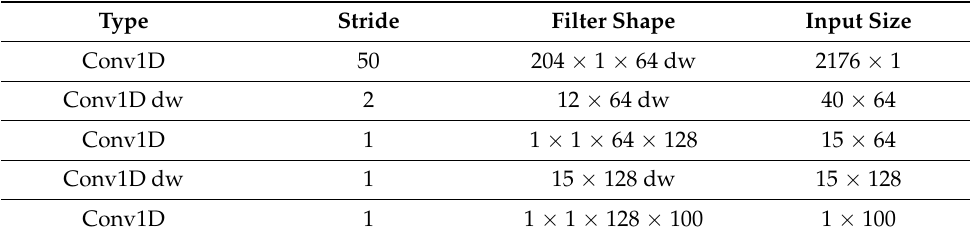
Figure 7. The depthwise separable convolutions with depthwise and pointwise layers followed by batch normalization (BN) and rectified linear unit (ReLU). Table 2. The structure of the learnable feature extractor.